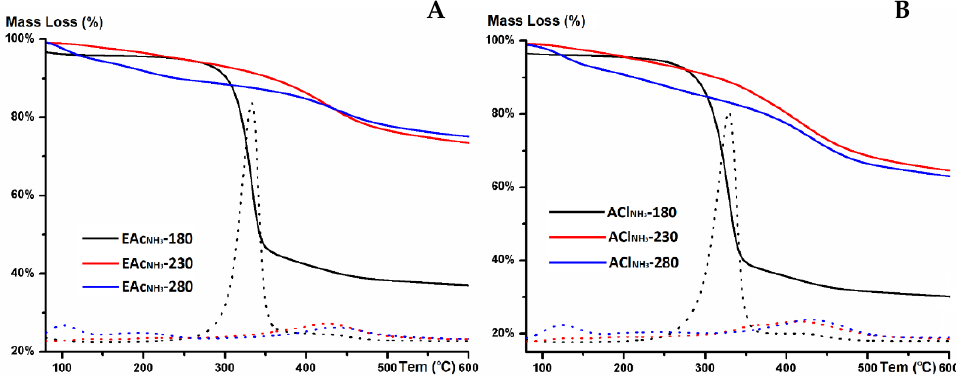
Figure 5. TGA (solid line) and DTA (dash line) analysis of Fe 3 O 4 @C nanoparticles EAc NH3 ( A ) and ACl NH3 ( B ) hydrocarbonized at different temperatures.